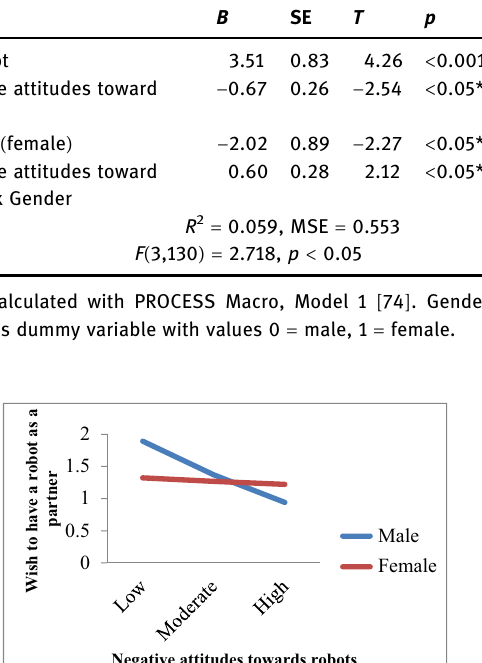
Table 10: Robots ’ roles and tasks at home and in public places Frequency Percent ( % ) ( N = 135 ) Robots ’ roles at home Helper